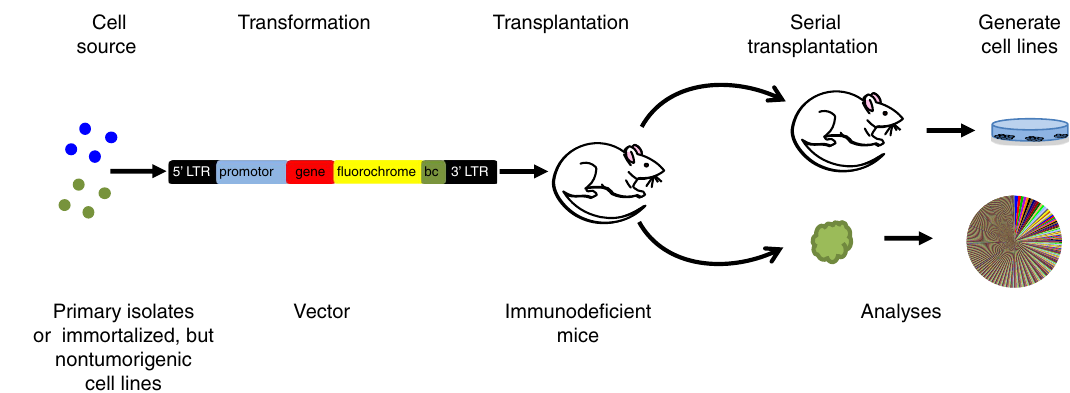
Figure 2 | De novo generation of tumours from ‘normal’ human cells. Most examples of successful transformation of primary sources of normal human cells (or non-tumorigenic human cell lines) have used retro- or lenti-viruses encoding one or more oncogenes and a fluorochrome (for example, GFP) to enable malignant cells to be later isolated and characterized. The transduced cells are then transplanted into a receptive site in immunodeficient mice. When a tumour forms, the cells can then be removed for morphological, immunohistochemical, flow cytomteric and/or various molecular and clonal analyses. When this method is efficient, polyclonal tumours may be generated (as illustrated by the pie chart). Retrieved viable cells can also be further transplanted or may be used to generate cell